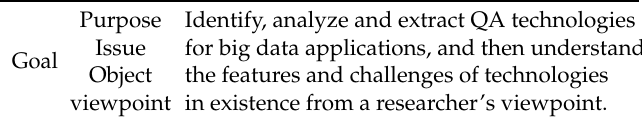
Table 2. Goal of this research.